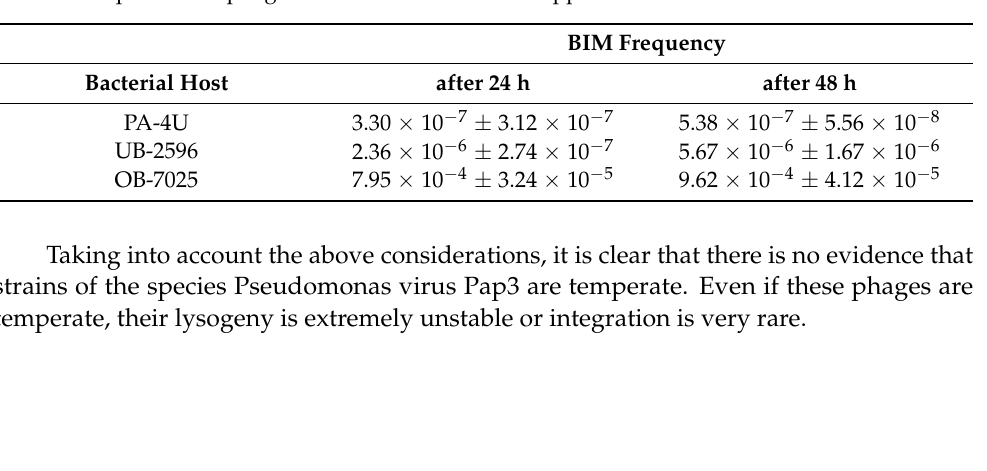
Table 2. Frequencies of phage Delta insensitive mutant appearance of various